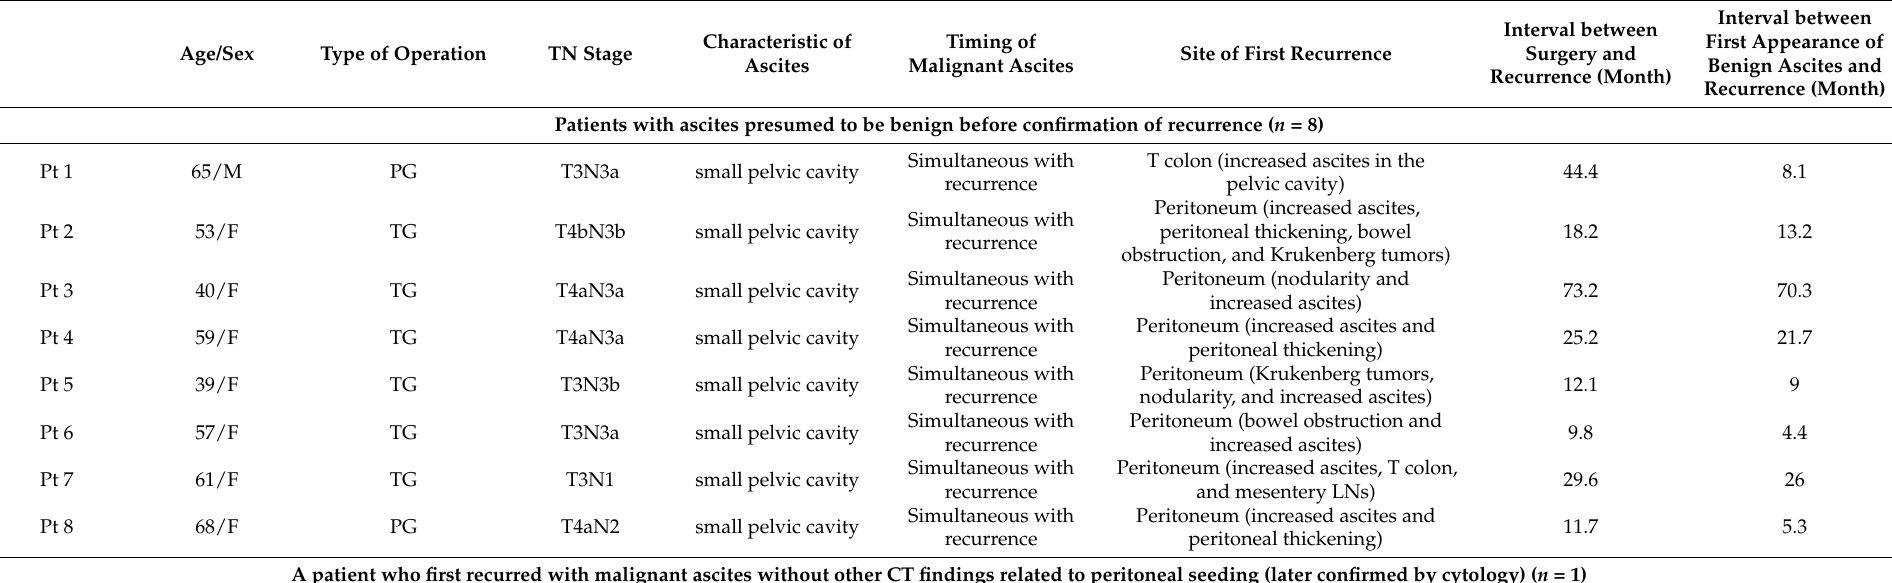
Table 3. Characteristics of patients with temporarily undefined